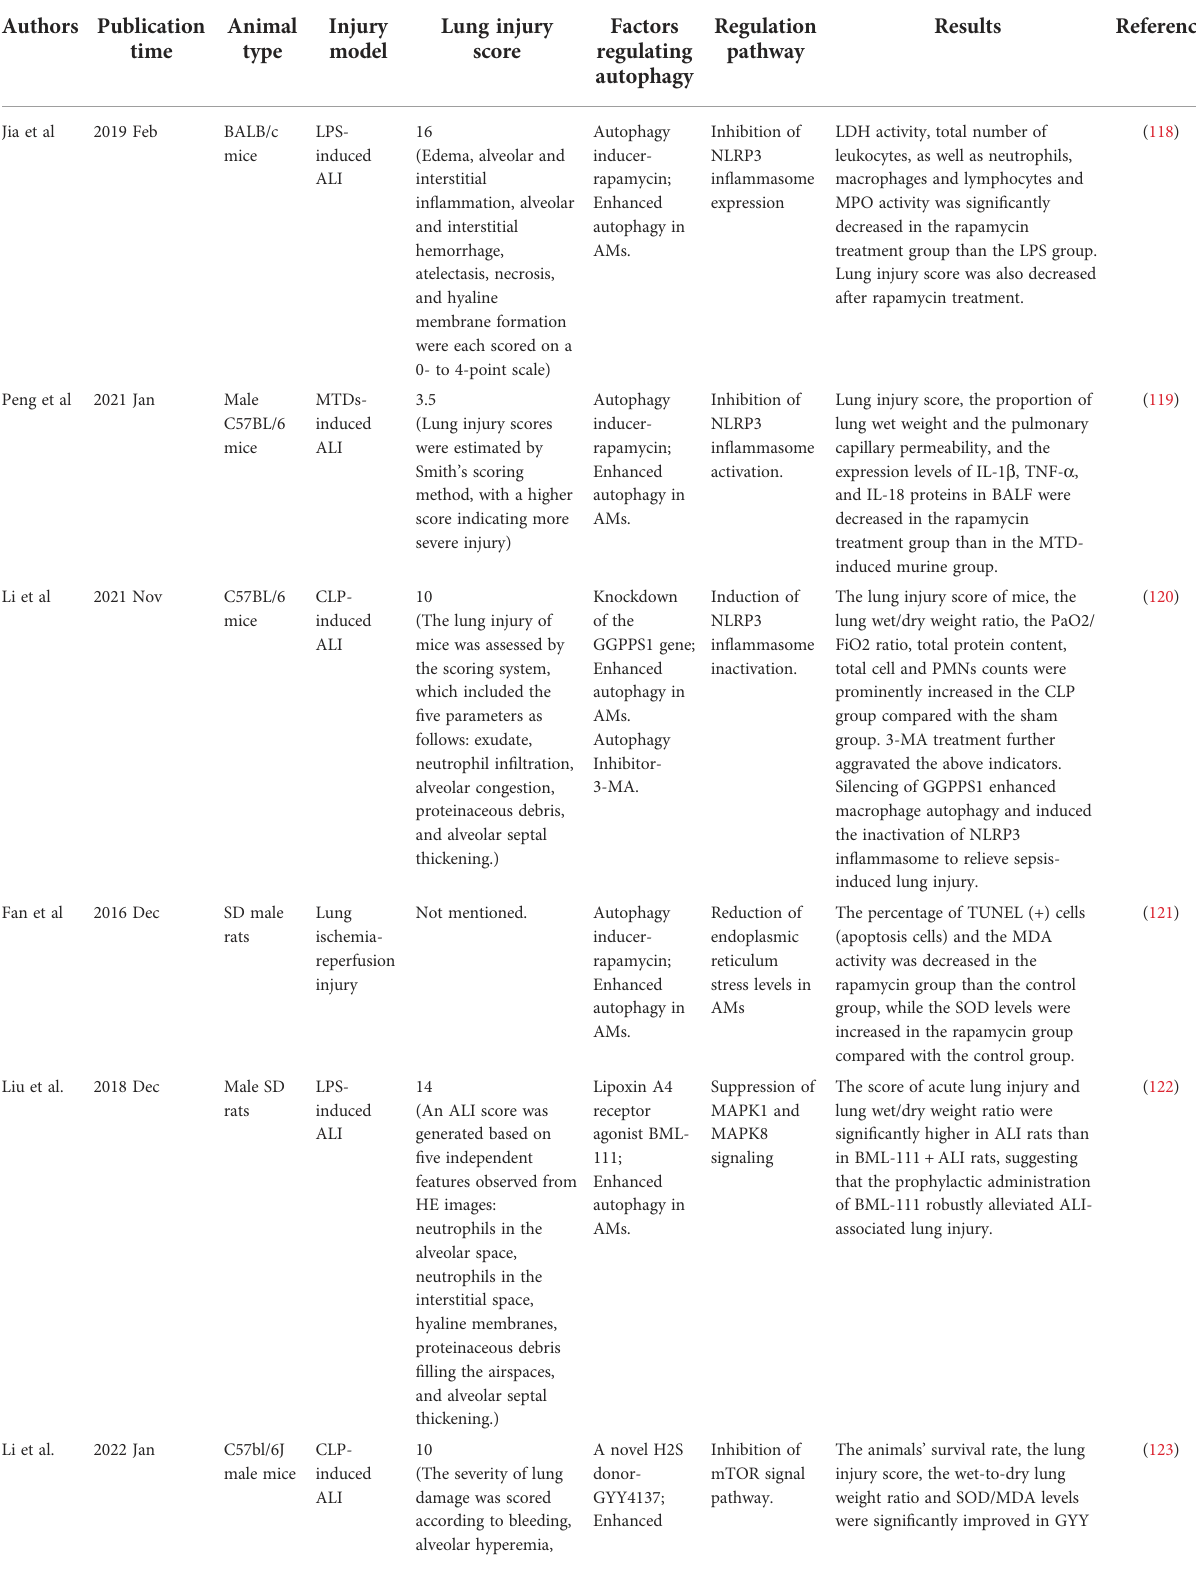
TABLE 1 Macrophage autophagy can reduce lung injury in animal